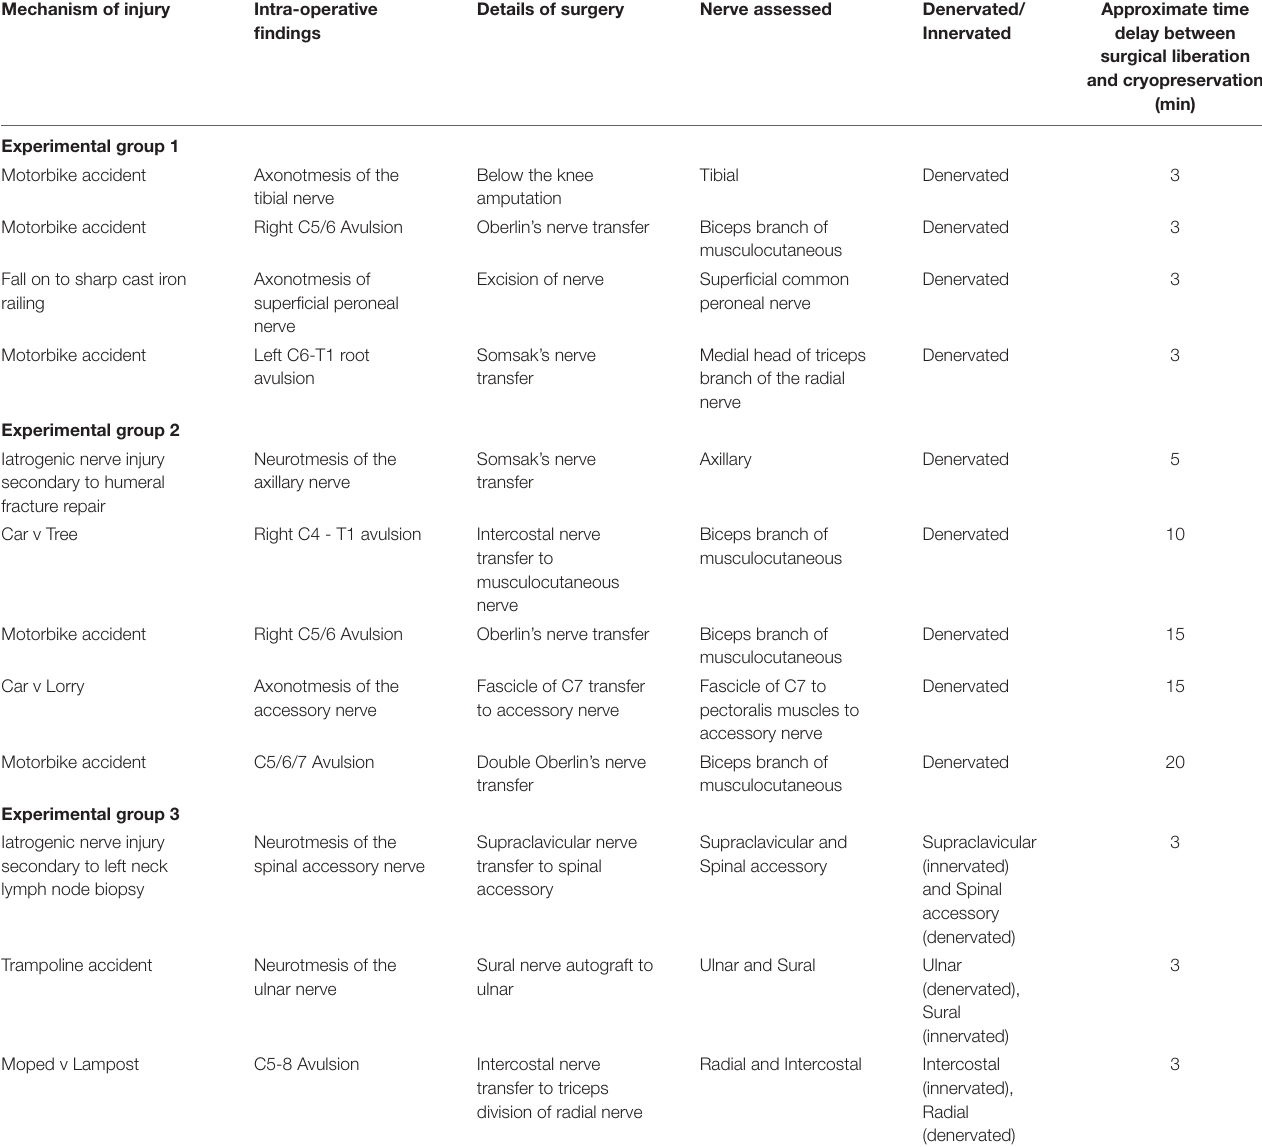
TABLE 1 | Demographic of patients and samples included in this